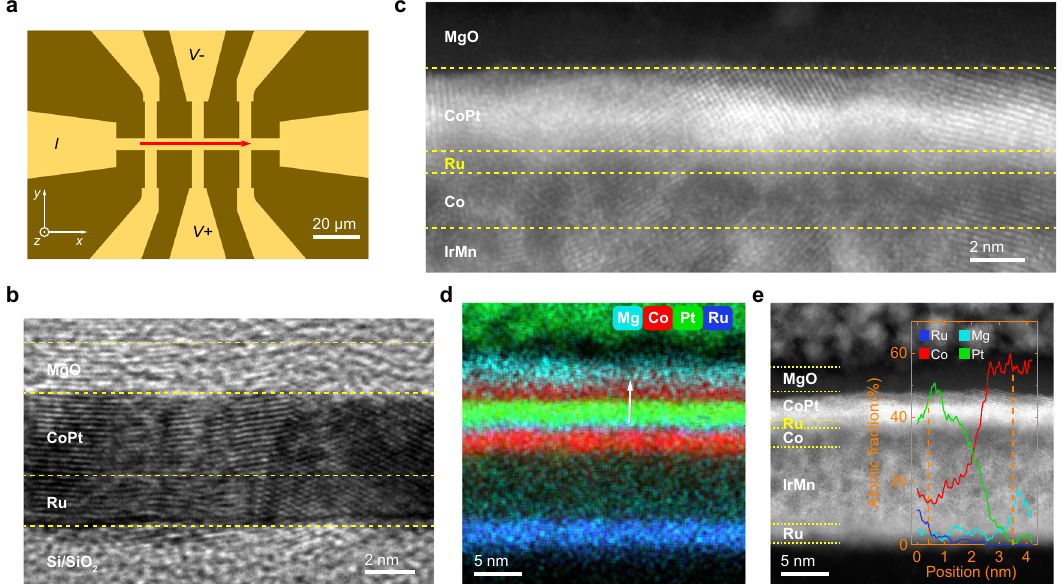
Fig. 1 Microstructure and composition characterization. a An optical micrograph of the fabricated 70 μ m × 5 μ m Hall bar. b The high resolution cross- section transmission electron microscopy image of the CoPt alloy single-layer fi lm with the nominal multilayered structure of Pt(0.7)/Co(0.3)/Pt(0.5)/Co (0.5)/Pt(0.3)/Co(1), which is grownn on Ru/Si buffer/substrates and capped by MgO protective layer. c the enlarged high-angle annular dark- fi eld (HAADF) images, d the elemental mapping, e the HAADF images of the Ru(2)/IrMn(8)/Co(2)/Ru(0.8)/CoPt(3.3)/MgO(2) heterojunction. Inset of e shows the line scanning of the EDS results marked by a white arrow in d . It is clear that the designed nominal multilayered structure of Pt(0.7)/Co(0.3)/ Pt(0.5)/Co(0.5)/Pt(0.3)/Co(1) has formed the single-layer CoPt alloy with an arti fi cial composition gradient in the thickness direction. In contrast, the Ru (2)/IrMn(8)/Co(2)/Ru(0.8)/CoPt(3.3)/MgO(2) heterojunction still keeps a good multilayered